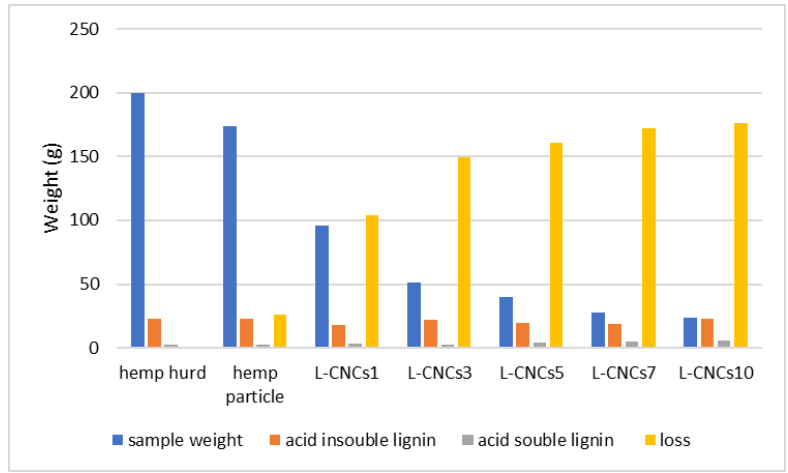
Figure 2. Mass balance calculated from the data reported in Table 1 (all samples have the same total weight).